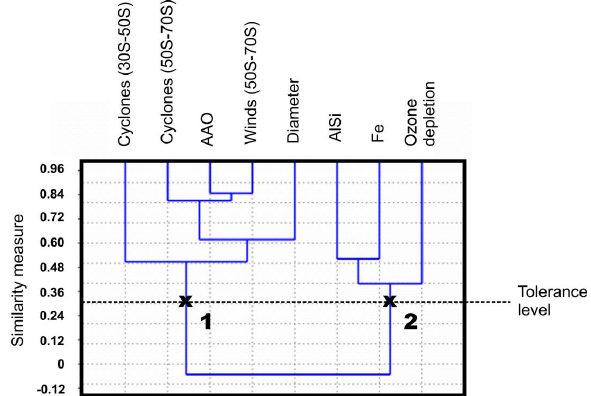
Fig. 4. Dendrogram showing the similarity level among the geo- chemical and climate parameters. In this case the algorithm used is the single linkage, and Pearson’s r correlation was the similar- ity measure. A tolerance level defined around 0.3 grouped 2 sets of